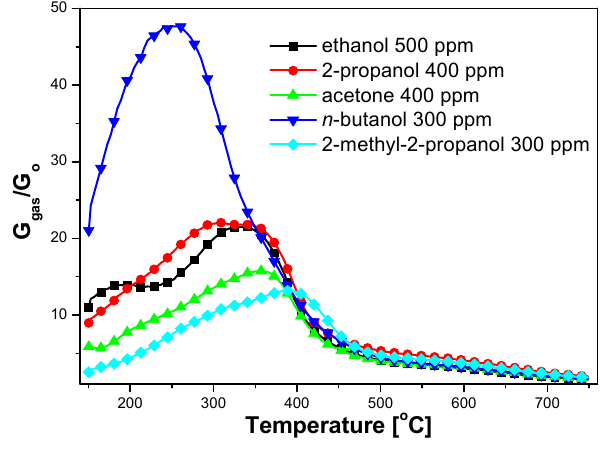
Figure 5. Temperature dependence of sensors sensitivity in the presence of different organic compounds.